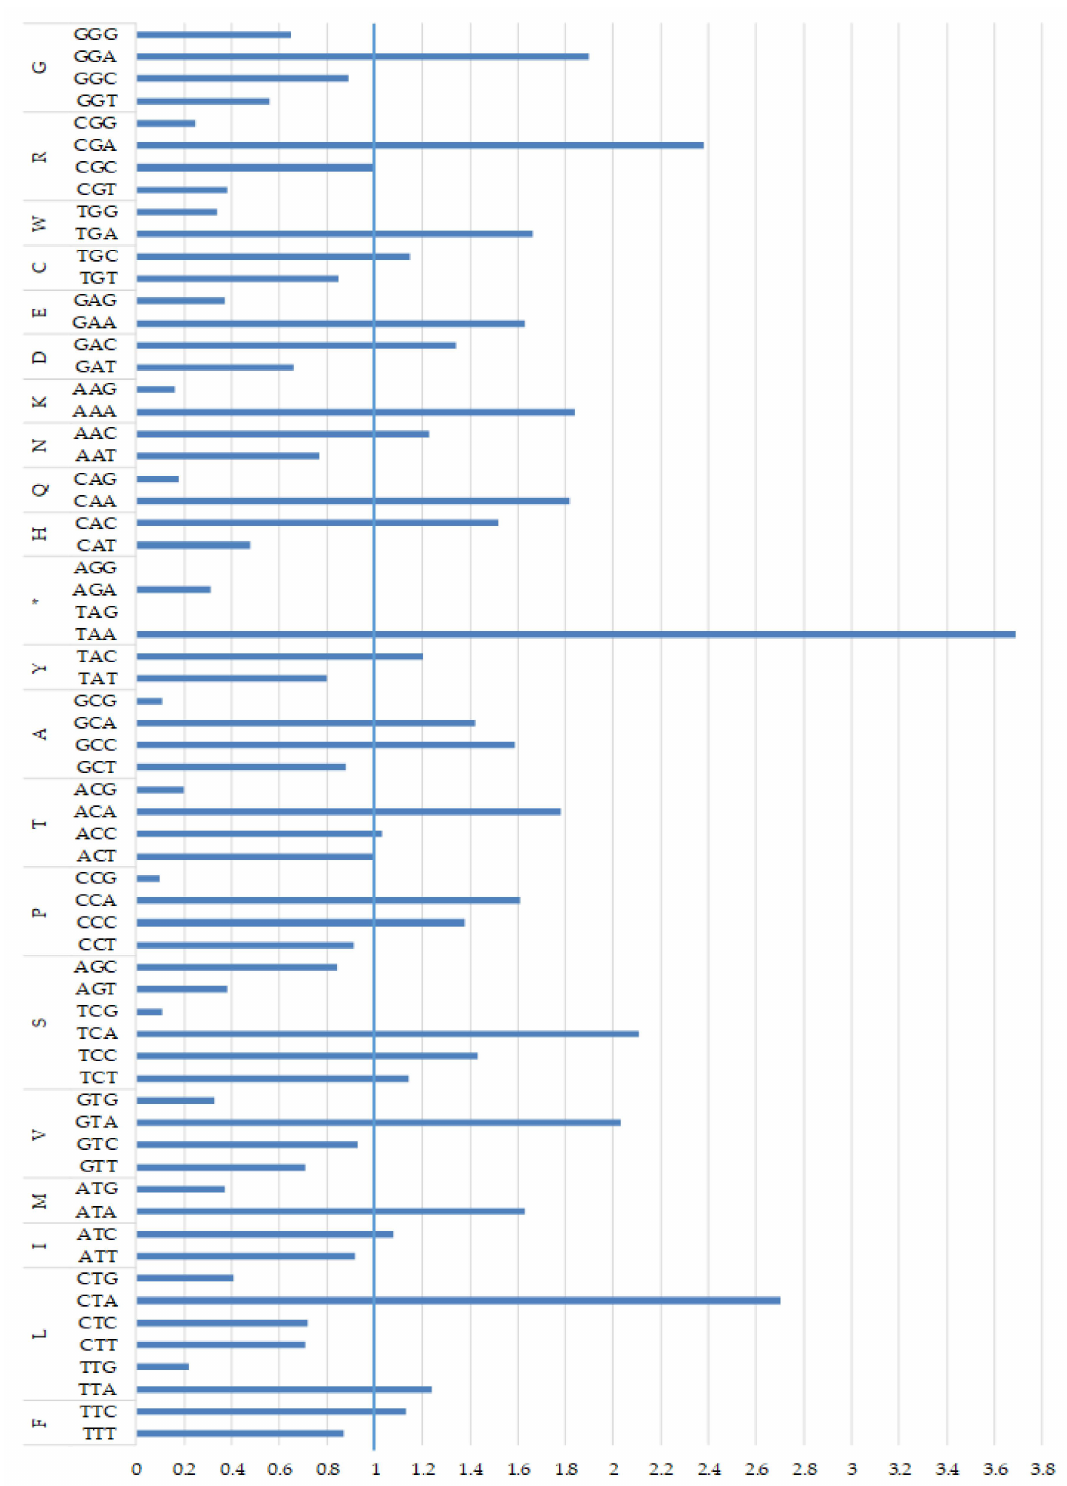
Figure 3. Relative synonymous codon usage (RSCU) in the mitochondrial genome of Mustela lutreola , including presumed polyadenylated incomplete termination codons [31] (RSCU = the actual number of synonymous codons used to translate specific amino acids/the expected number; when the observed values of synonymous codons are the same as the expected values, RSCU = 1, and the codons are not biased, when RSCU > 1, the codons are positively biased, and when RSCU < 1, the codons are negatively biased [32]; * termination